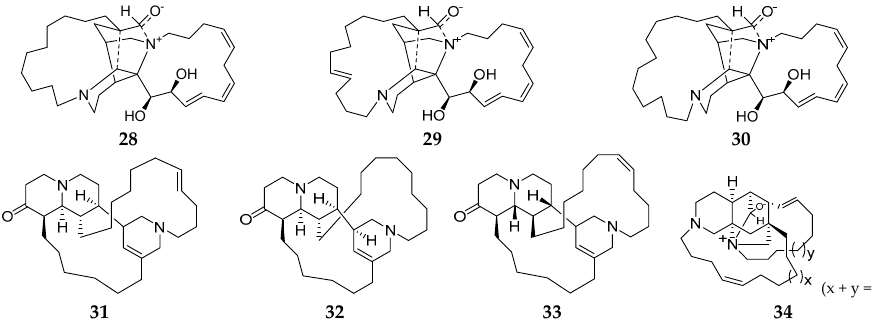
Figure 3. Macrocyclic diamines derivatives 28 – 34 from the subgenus Reniera .